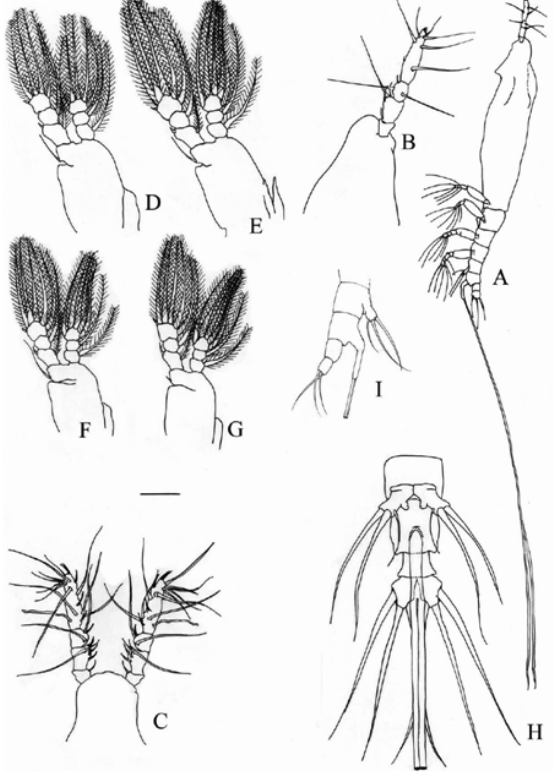
Fig. 2 – Cymbasoma longispinosum Bourne, 1890, f#. (A) Female lateral view; (B) Lateral view of the head; (C) Dorsal view of the head; (D) Leg 1; (E) Leg 2; (F) Leg 3; (G) Leg 4; (H) Ventral view of the urosome; (I) Lateral view of the urosome. Scale bar: A = 0.6 mm; B, C and I = 0.3 mm; D, E, F, G and H = 0.15 mm.